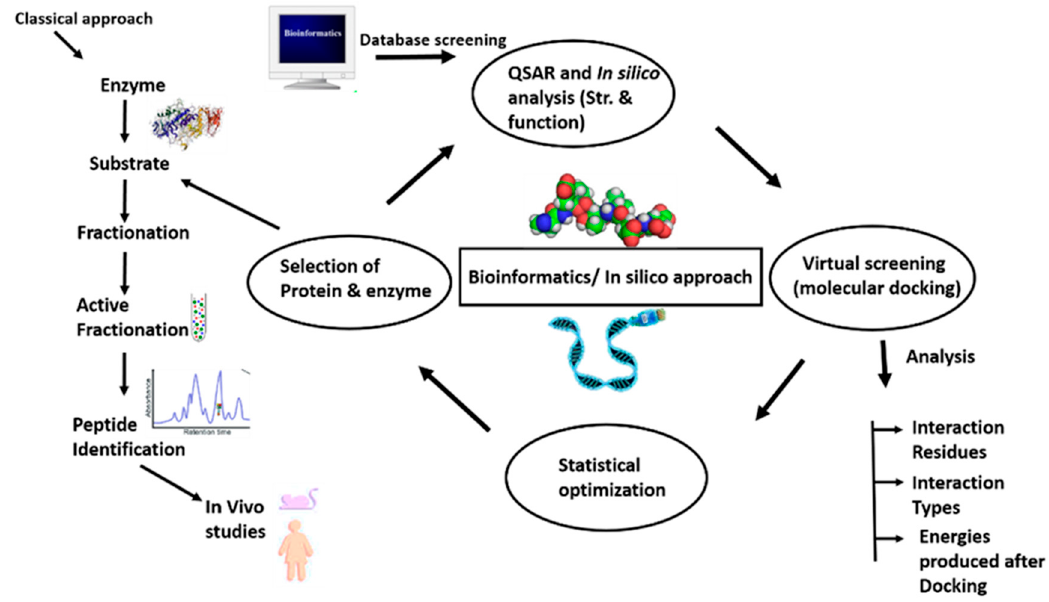
Figure 3. Representation of integrated approach (conventional / classical and bioinformatics) for the identification of food-derived bioactive peptides.